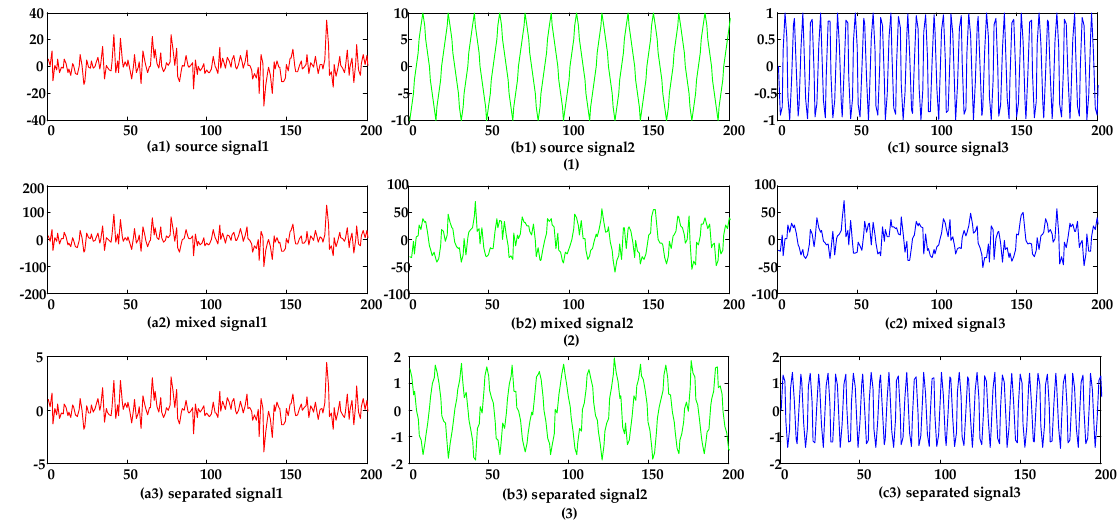
Figure 3. ( a1 ) The waveform of the first source signals; ( b1 ) The waveform of the second source signals; ( c1 ) The waveform of the third source signals; ( a2 ) The waveform of the first mixed signals; ( b2 ) The waveform of the second mixed signals; ( c2 ) The waveform of the third mixed signals; ( a3 ) The waveform of the first separated signals; ( b3 ) The waveform of the second separated signals; ( c3 ) The waveform of the third separated signals.